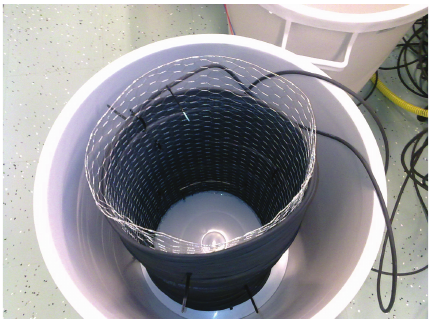
Figure 2: The cable was wrapped around a metal frame which was positioned inside the plastic tub.